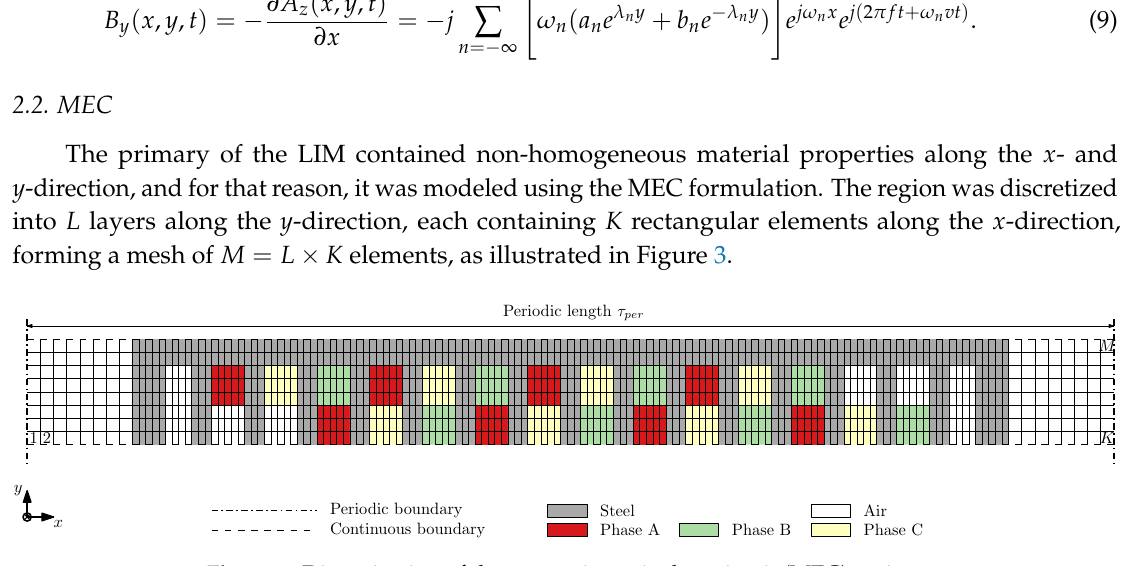
Figure 3. Discretization of the magnetic equivalent circuit (MEC) region.